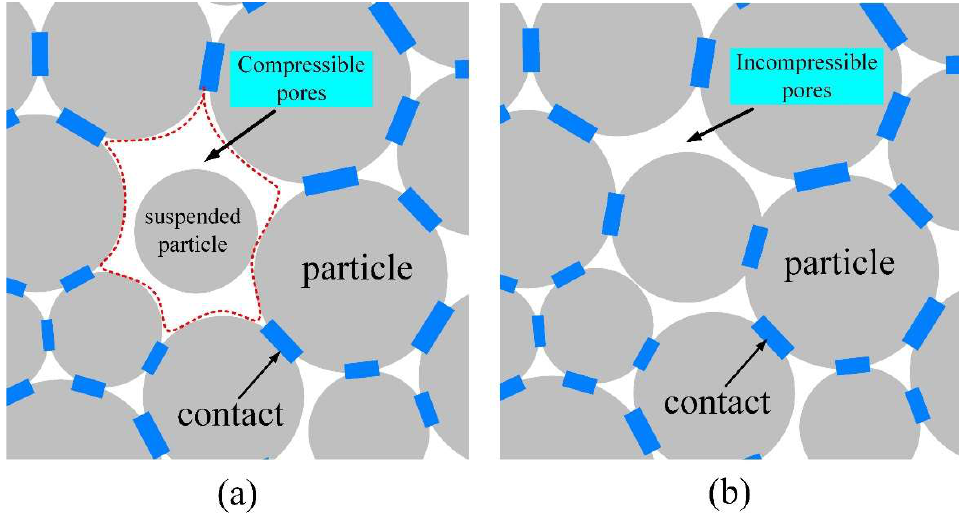
Figure 15. Effect of suspended particles on modelling. ( a ): existing suspended particles ( b ): without suspended particles.